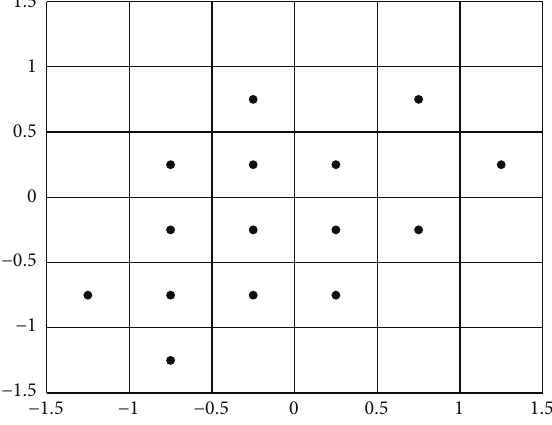
Table 1: DE control parameters as used in the literature.